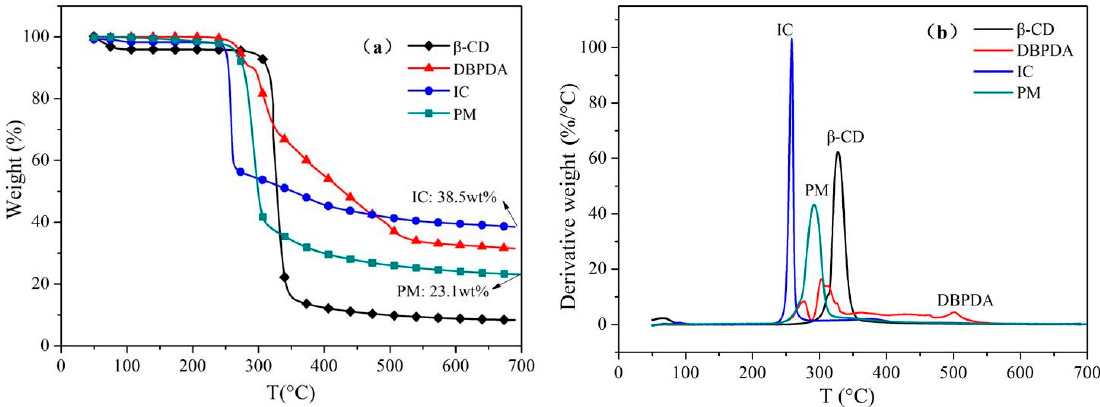
Figure 5. ( a ) TGA and ( b ) DTG curves of β -CD, DBPDA, IC and PM under N 2 .